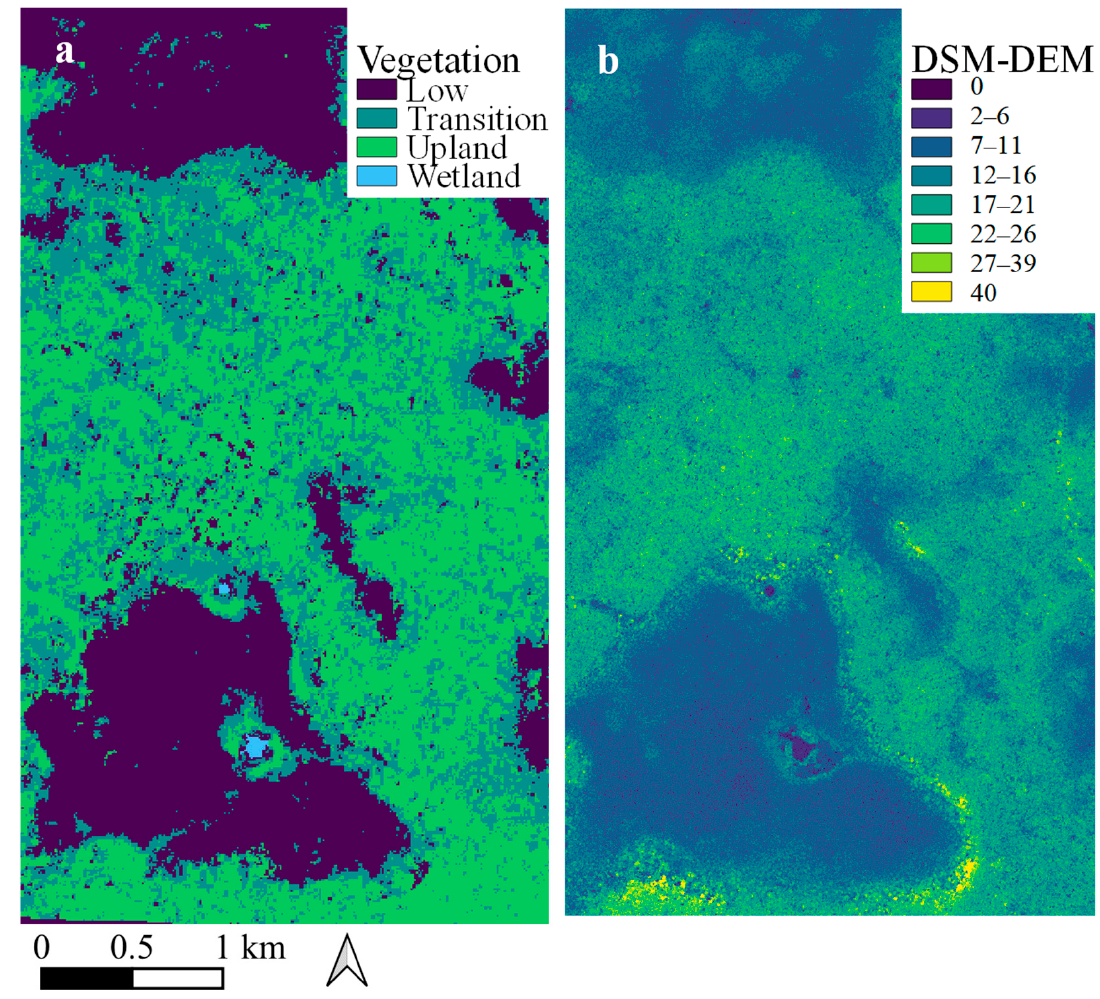
Figure 4. ( a ) Vegetation classification of the Yaxnohcah study site over a Sentinel-2 satellite image. ( b ) Tree heights obtained from the difference between the Digital Surface Model and the Digital Elevation Model from lidar data.